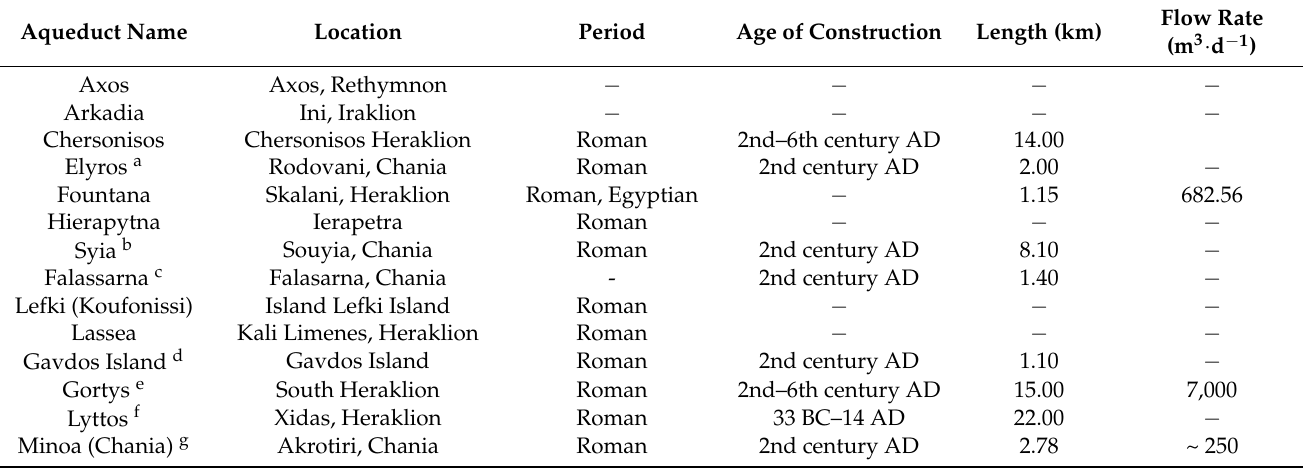
Table 2. Characteristics of selected Roman aqueducts (adapted from [21–23]).